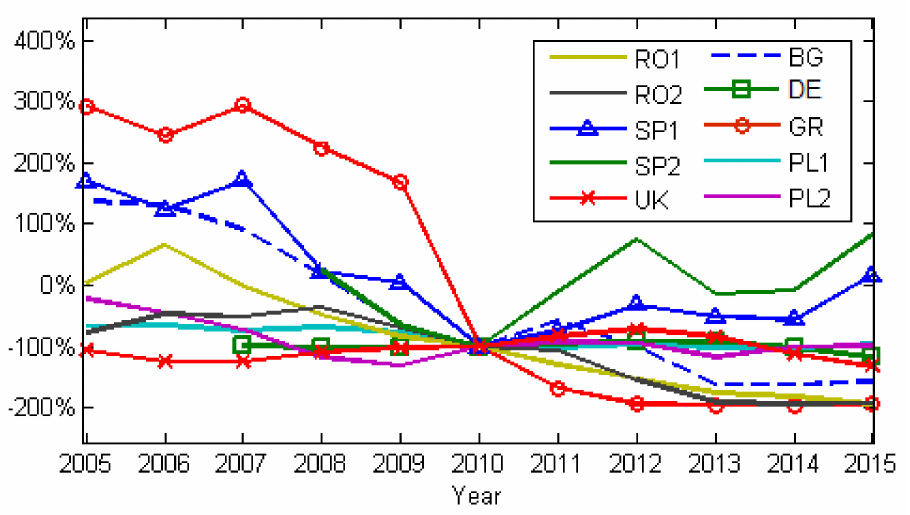
Figure 10. Changes in SO 2 emissions relative to 2010, the milestone being NEC Directive.